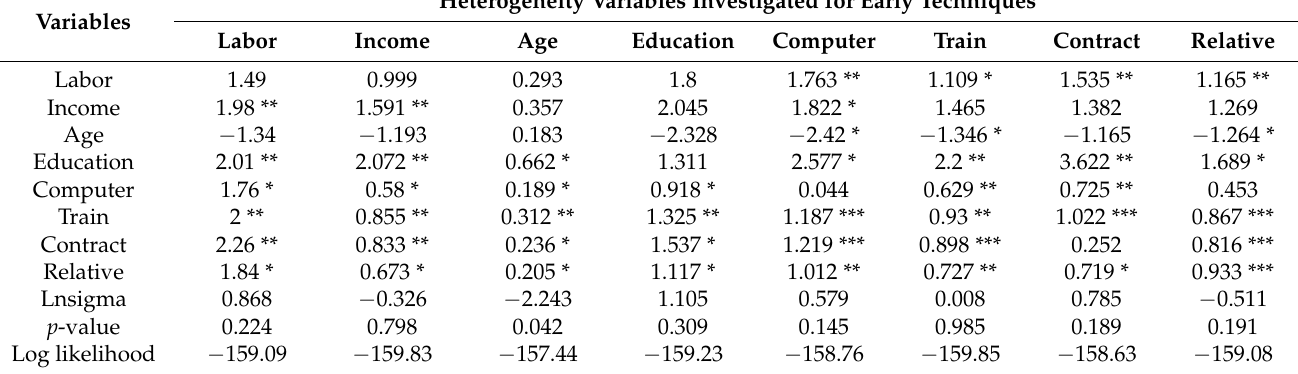
Table 7. Heterogeneity test and results for early techniques.